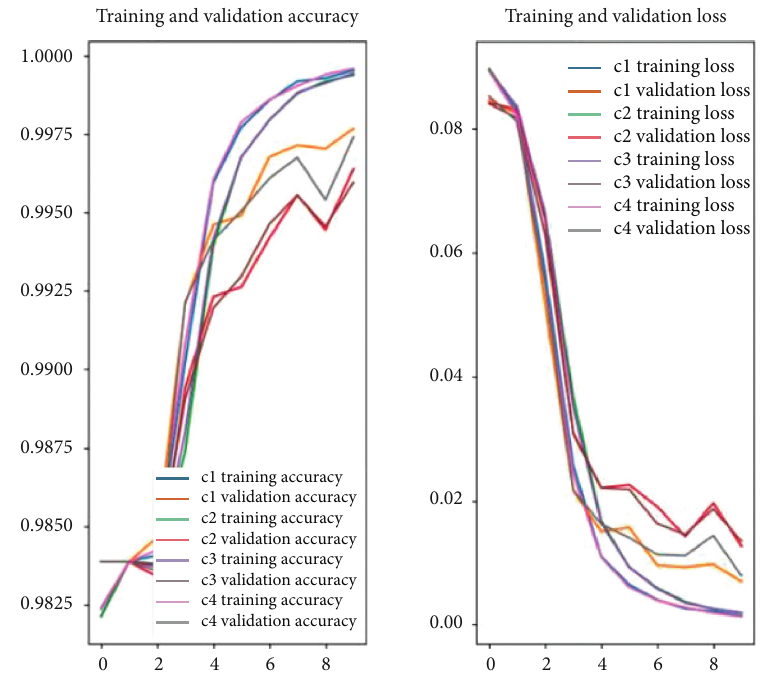
Figure 9: Curve of accuracy and loss value on random generated CAPTCHA.